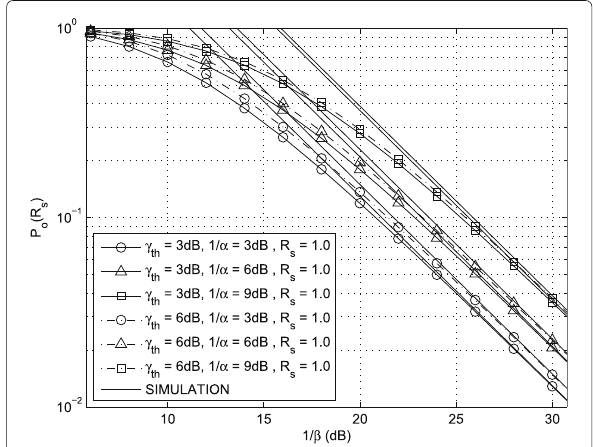
Fig. 4 Outage probability with no direct link between both S − D and S − E for 1 /α = 3,6 , and 9 dB, γ th = 3 and 6 dB and R s = 1.0 of single balanced relay system